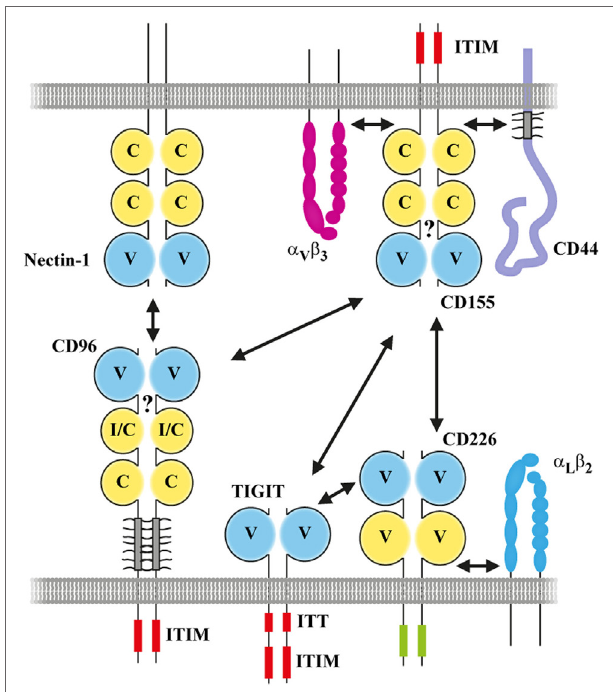
FiGURe 2 | Interactions in cis and in trans providing the platform for CD96 functions in the context of the CD155 network. Interactions are indicated by two-sided arrows in black. The question mark indicates that it was not shown so far whether CD96 can form a cis -homodimer on the cell surface. Red boxes: ITT and ITIM, respectively. Green box: the cytoplasmic domain of CD226 containing a tyrosine and serine residue critically involved in signaling (Y 322 and S 329 in human). Not all interactions that can be engaged by CD155 family members are shown. Moreover, the associations shown in cis between CD155 family members and partner molecules are cell type specific and/or depend on a cells activation status. Please note that the molecular proportions of the given molecules are not drawn to scale to highlight the interactions between CD155 family